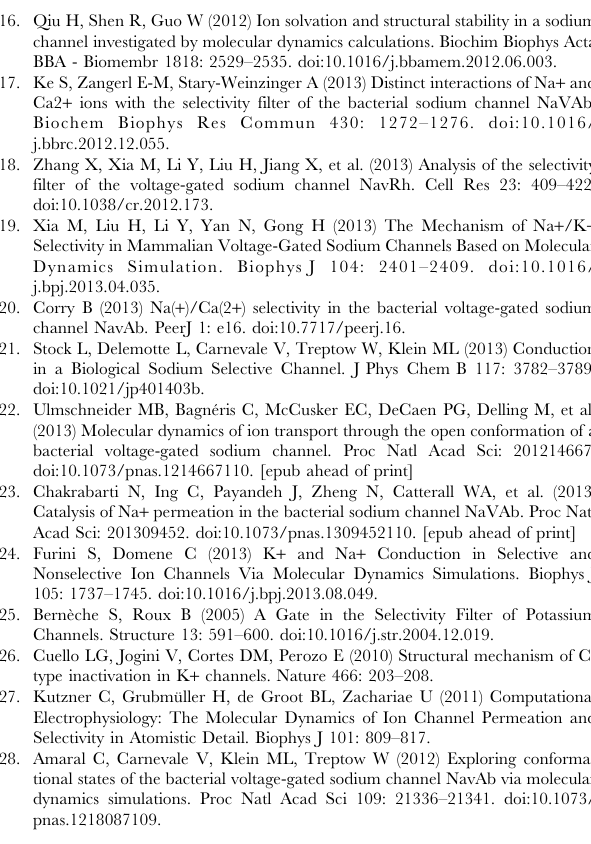
Figure S2 Cumulative ion flux counts with flip counts as a function of time from simulation 2 without dihedral restrains of E53. A) & C) Ion flux counts through the SF and flipping counts of E53 over 400 ns trajectory of inward simulation (color: blue). B) & D) Ion flux counts through the SF and flipping counts of E53 in over 400 ns trajectory of outward simulation (color: red). Figure S3 Cumulative ion flux counts with flip counts as a function of time from simulation 3 without dihedral restrains of E53. A) & C) Ion flux counts through the SF and flipping counts of E53 over 400 ns trajectory of inward simulation (color: blue). B) & D) Ion flux counts through the SF and flipping counts of E53 in over 400 ns trajectory of outward simulation (color: red). Figure S4 Cumulative ion flux counts with flip counts as a function of time from simulation 4 without dihedral restrains of E53. A) & C) Ion flux counts through the SF and flipping counts of E53 over 400 ns trajectory of inward simulation (color: blue). B) & D) Ion flux counts through the SF and flipping counts of E53 in over 400 ns trajectory of outward simulation (color: red). Figure S5 Hydration shell of the simulations without dihedral restrains of E53. (A) Oxygen coordination numbers in the first hydration shell for inward sodium conduction (Oxygen atoms closer than 3.0 A˚ to Na + were considered